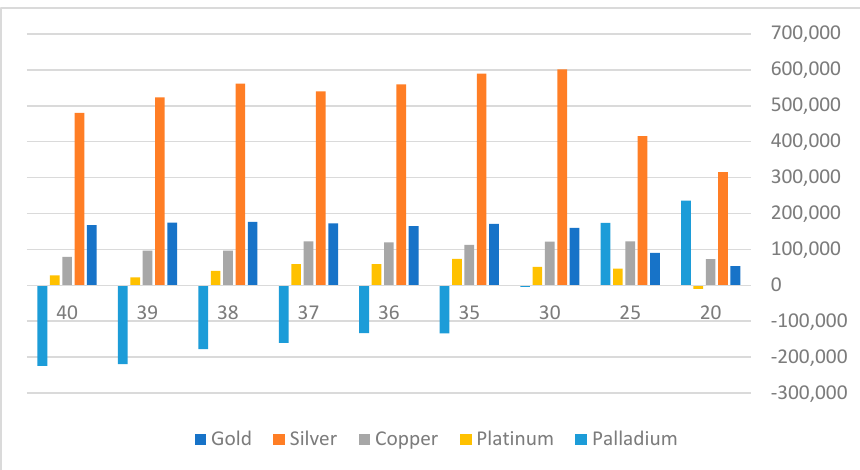
Figure 4. Net profits trading results of linear regression strategy .